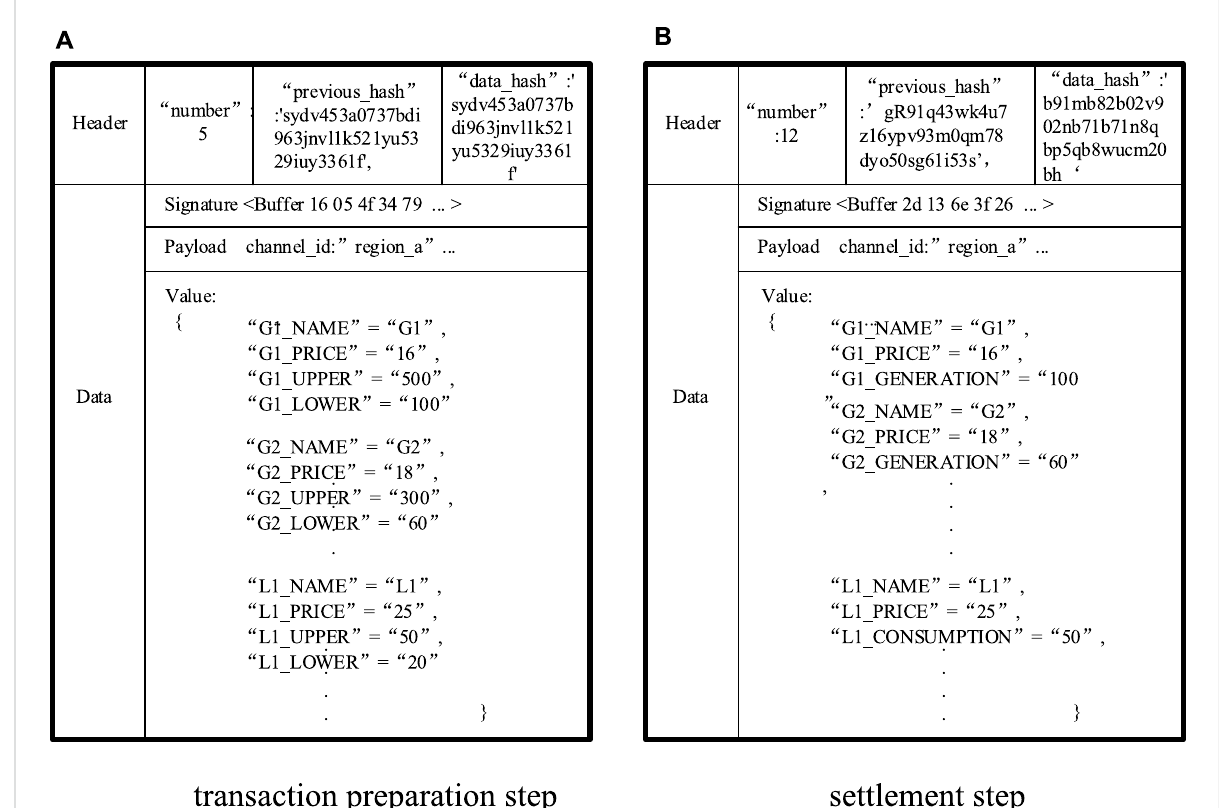
FIGURE 13 Schematic diagram of block information. (A) Transaction preparation step. (B) Settlement